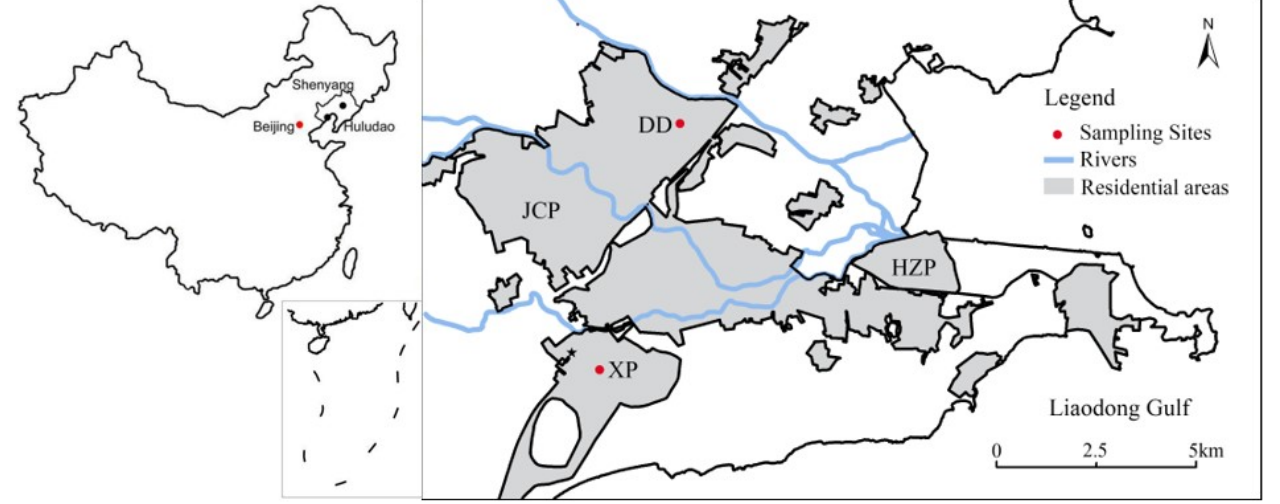
Figure 1. Study area and sampling sites. XP represents Xinqu Park sampling site; DD represents Dongcheng District sampling site; HZP represents Huludao Zinc Plant; JCP represents Jinxi Chemical Plant.